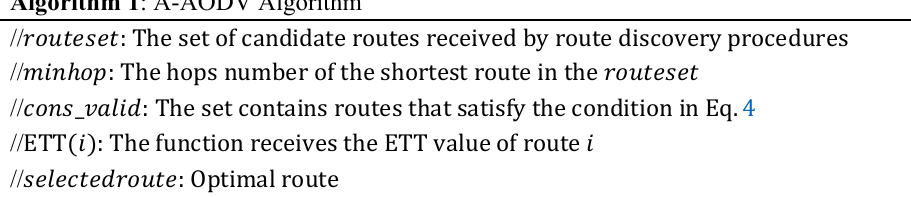
Algorithm 1 : A-AODV